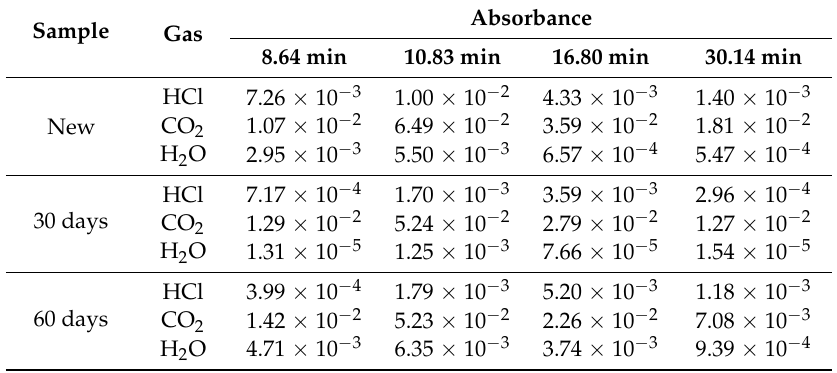
Table 3. Gases released from PVC sheaths in nitrogen atmosphere at a heating rate of 30 K min − 1 with different